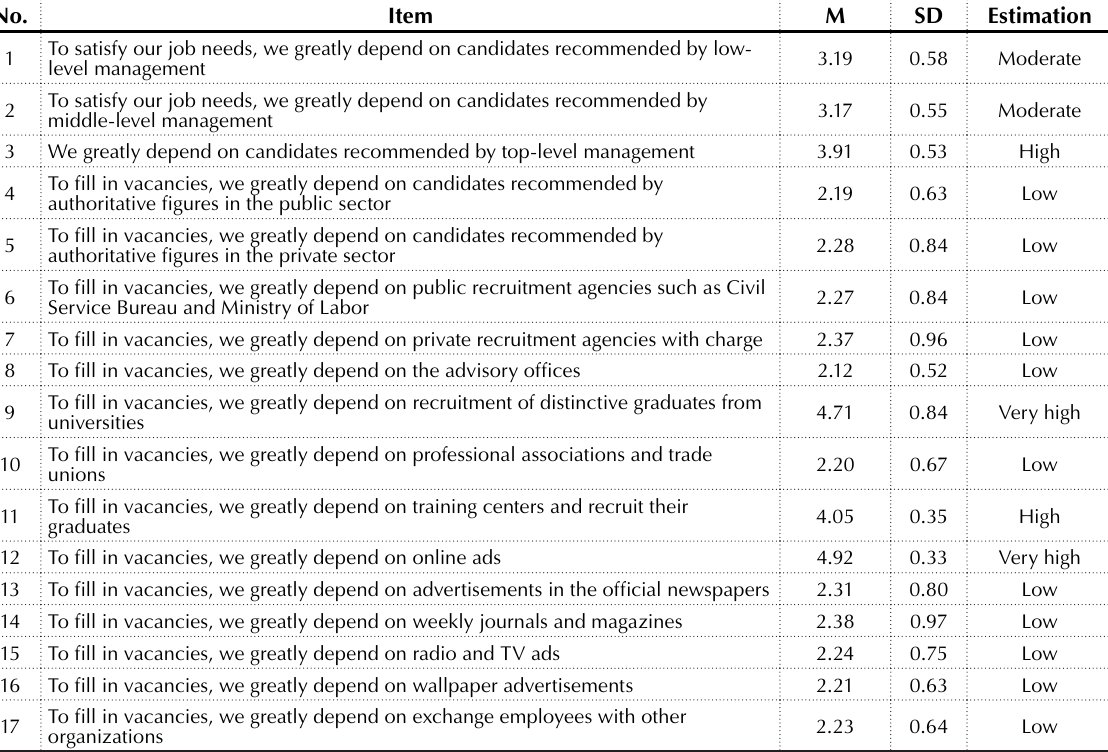
Table 2. Means, standard deviation levels of external recruitment sources No.